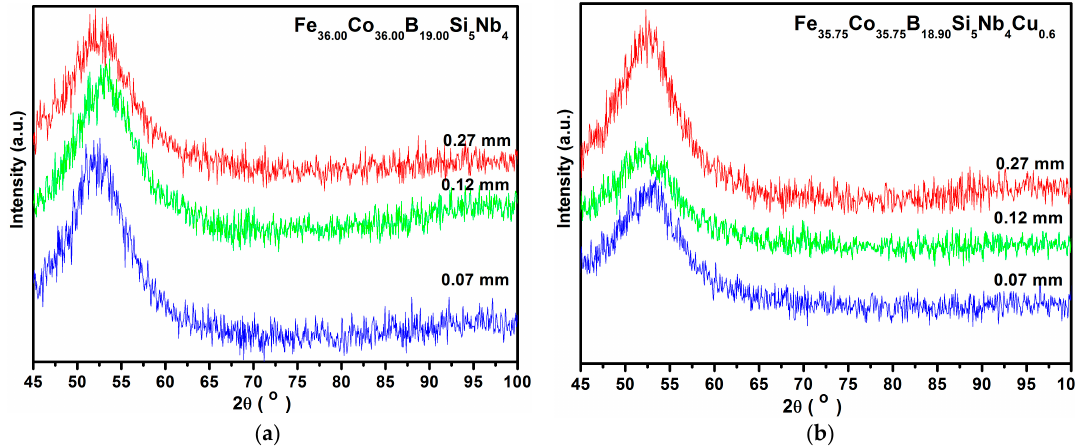
Figure 1. X-ray diffraction patterns of ( a ) Fe 36.00 Co 36.00 B 19.00 Si 5 Nb 4 and ( b ) Fe 35.75 Co 35.75 B 18.90 Si 5 Nb 4 Cu 0.6 alloys in ribbon form with thickness of 0.07, 0.12, and 0.27 mm.